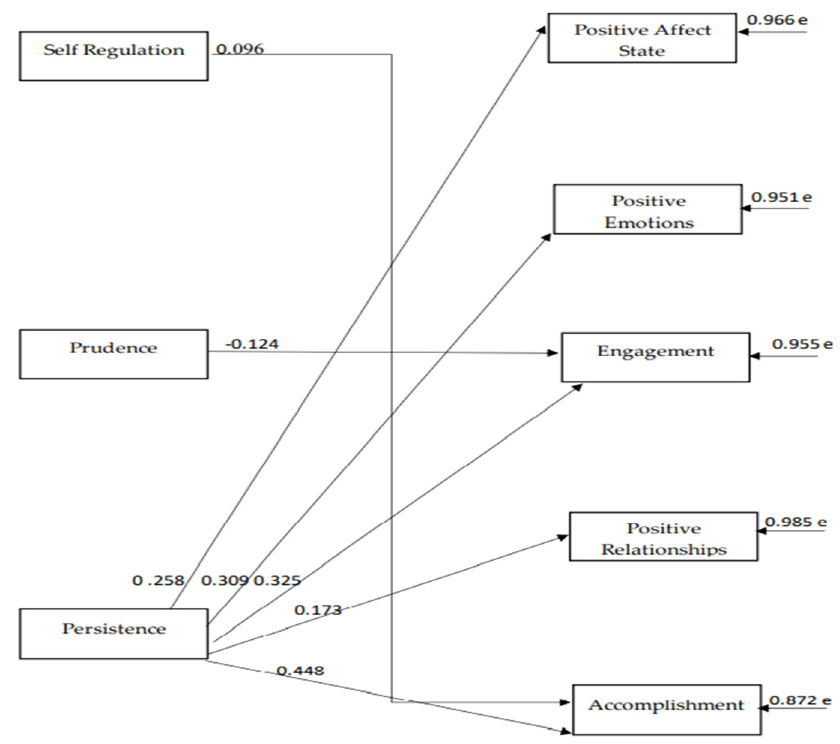
Figure 4. The relationships between virtue of restraint dimensions and subjective wellbeing com- ponents.